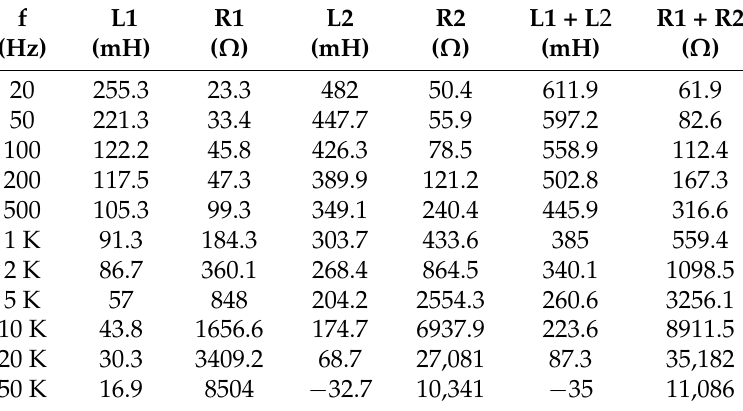
Table 4. The freezer motor R-L values with different frequencies.